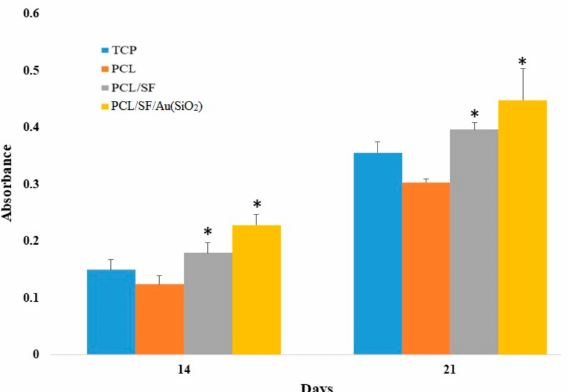
Figure 8. Alkaline phosphatase activity on TCP, PCL, PCL / SF and PCL / SF / Au(SiO 2 ) nanofibrous sca ff olds using hMSCs on day 14, and 21. * p <